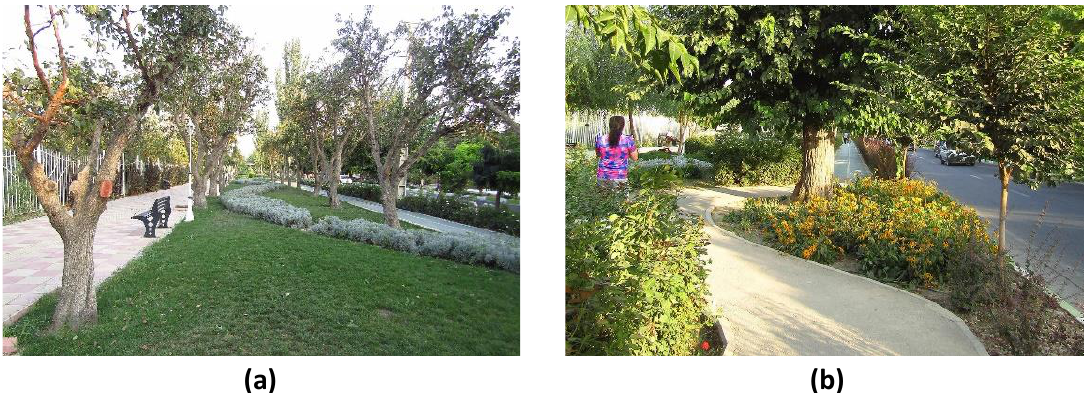
Fig. 7: (a) Some of the old fruit trees throughout the path; (b) The compatibility of bicycle path with existing field and old trees